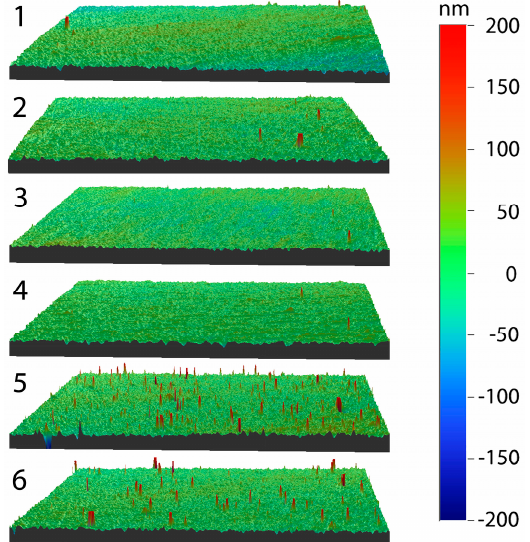
Figure 4. VSI images illustrating the surface for coatings for processes 1–6, the numbers in the figure refer to the process number. The corresponding R parameters are found in Table